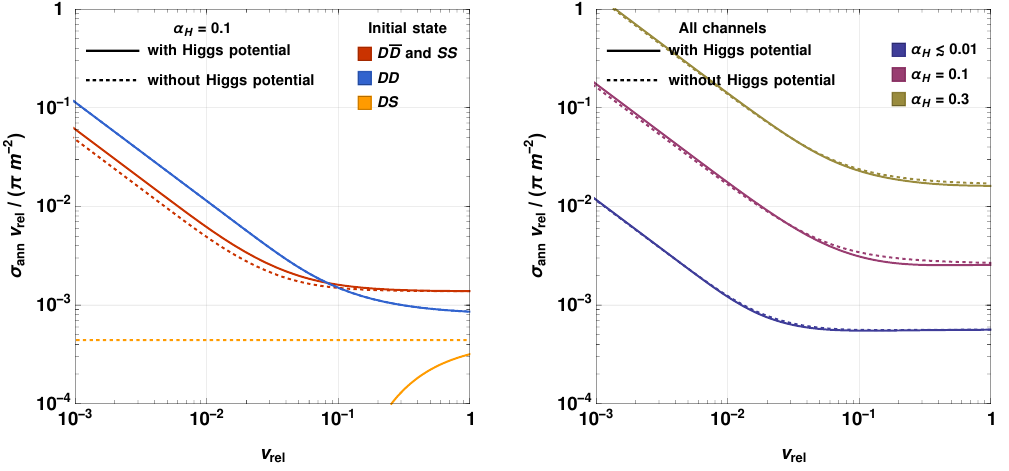
Figure 3 . The s -wave annihilation cross-sections, by initial state ( left ) and total ( right ), averaged over the dof of the incoming particles, with and without the Higgs-mediated potential (cf. table 5). Because the processes affected by the latter have either low multiplicity or small perturbative cross- sections, the Sommerfeld effect at low velocities arises mostly due to the B µ and W µ gauge bosons. For α . 0 . 01 , the perturbative annihilation cross-section is also not substantially affected by the H coupling to the Higgs (right panel, blue line). Note that we have weighted the contribution of each annihilation channel with the number of DM particles eliminated in each process as estimated upon thermal averaging (cf. ref.